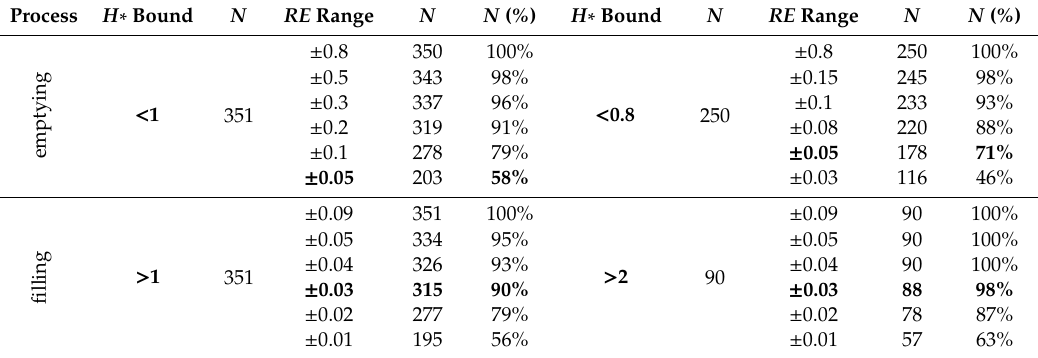
Figure 10. For H ∗ > 1, two di ff erent 3D views ( a ) from the bottom and ( b ) from the top of the stage variation–discharge relationship (Equation (29)). The triplet of the experimental values ( H ∗ , ρ ∗ , and τ ∗ ) (red dots) and the surface (in yellow), corresponding to the limiting condition, are also plotted. Table 8. For the considered emptying and filling processes, sample size of the disaggregated data for the whole data set and for the data set limited by H ∗